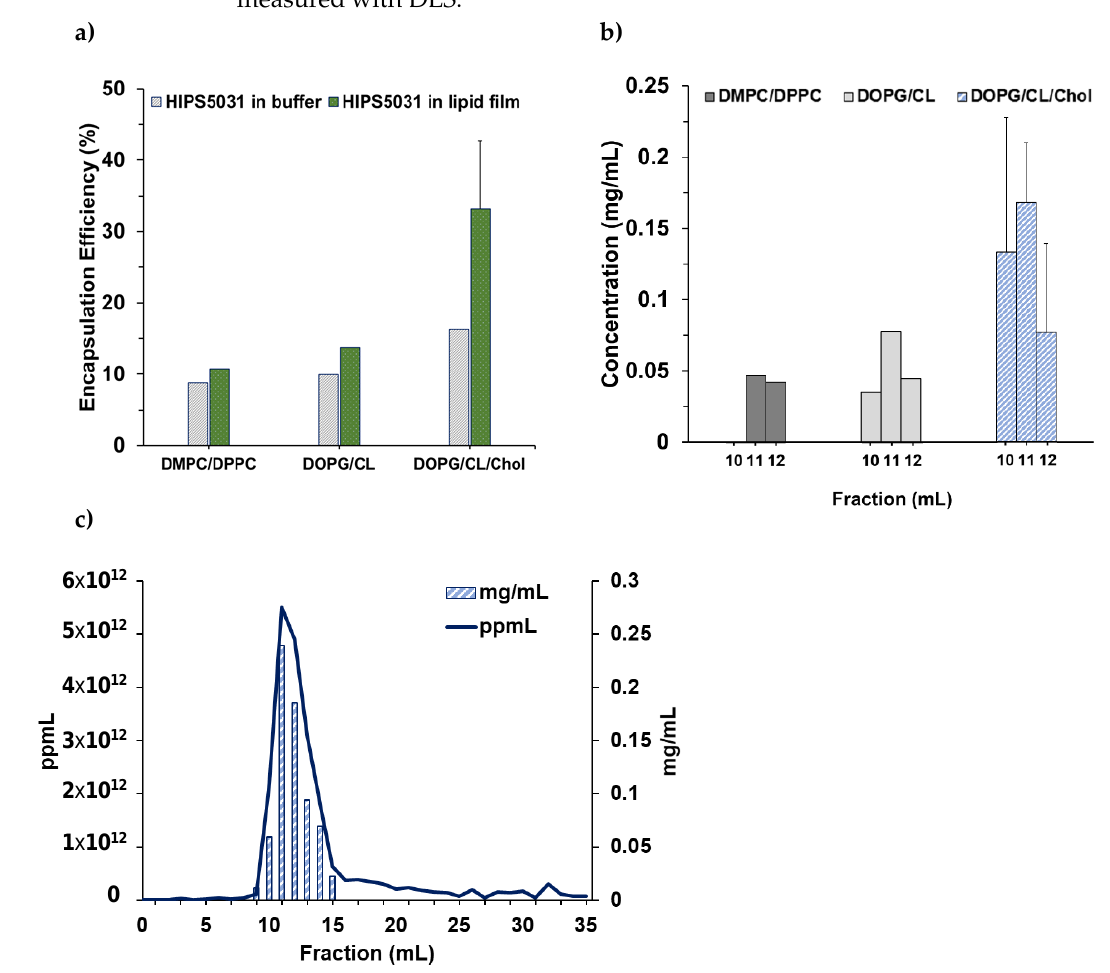
Figure 3. Encapsulation of HIPS5031 into liposomes. ( a ) Encapsulation efficiency (%): bacteri- omimetic and control (PC) liposomes were loaded either by rehydration of a pure lipid film with a drug-PBS solution or by rehydration of a drug-containing lipid film with PBS; ( b ) concentration of HIPS5031 in particle-rich SEC-fractions as determined by HPLC-MS analysis (DOPG/CL/Chol n = 5); ( c ) SEC profile of DOPG/CL/Chol liposomes loaded with HIPS5031 . The particle concentration of fractions was determined by NTA, and the drug concentration was determined by HPLC-MS.